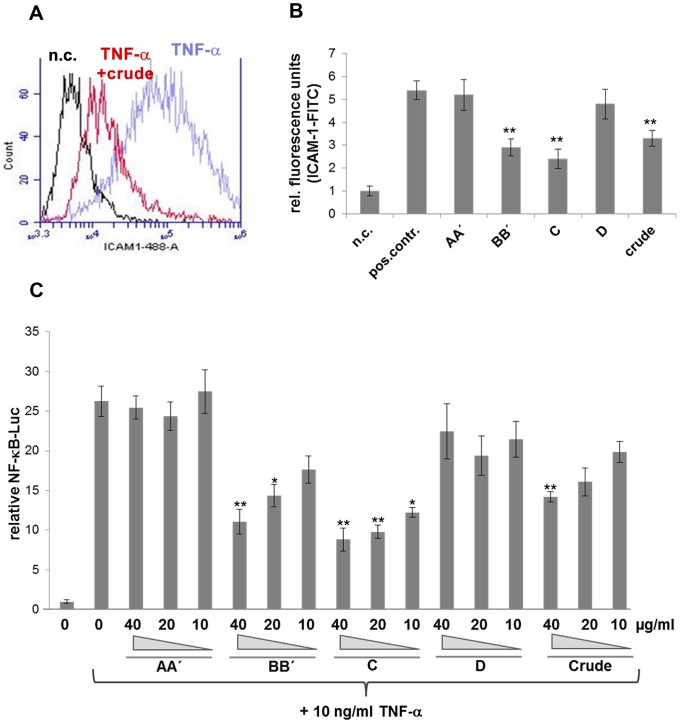
Screening for anti-inflammatory T. wortmannii components.(A) Flow cytometric analysis of ICAM-1 expression on the cell surface of HUVECs. Cells were stimulated with 10 ng/ml hTNF-α with or without 25 µg/ml crude extract or left untreated as negative control and stained with mouse anti-human ICAM-1 mAB. (B) Screening for anti-inflammatory substances, using a cell-based ELISA. Cells were treated for 1h in the absence or presence of 25 µg/ml substances AA, BB, C, D and crude extract, prior to being stimulated for 24 h with 10 ng/ml hTNF-α and stained with human ICAM-1 mAB (C) HEK293 cells were transiently transfected with NF-κB-Luciferase construct and EGFP construct. 24 h later, transfected cells were treated with 0, 40, 20 or 10 µg/ml substances or crude extract, prior to being stimulated with 10 ng/ml hTNF-α. Luciferase activities was determined 8 h later, normalized to the EFGP activities and expressed as fold increase over the control. (*, p<0.05; **, p<0.01, Students t test).